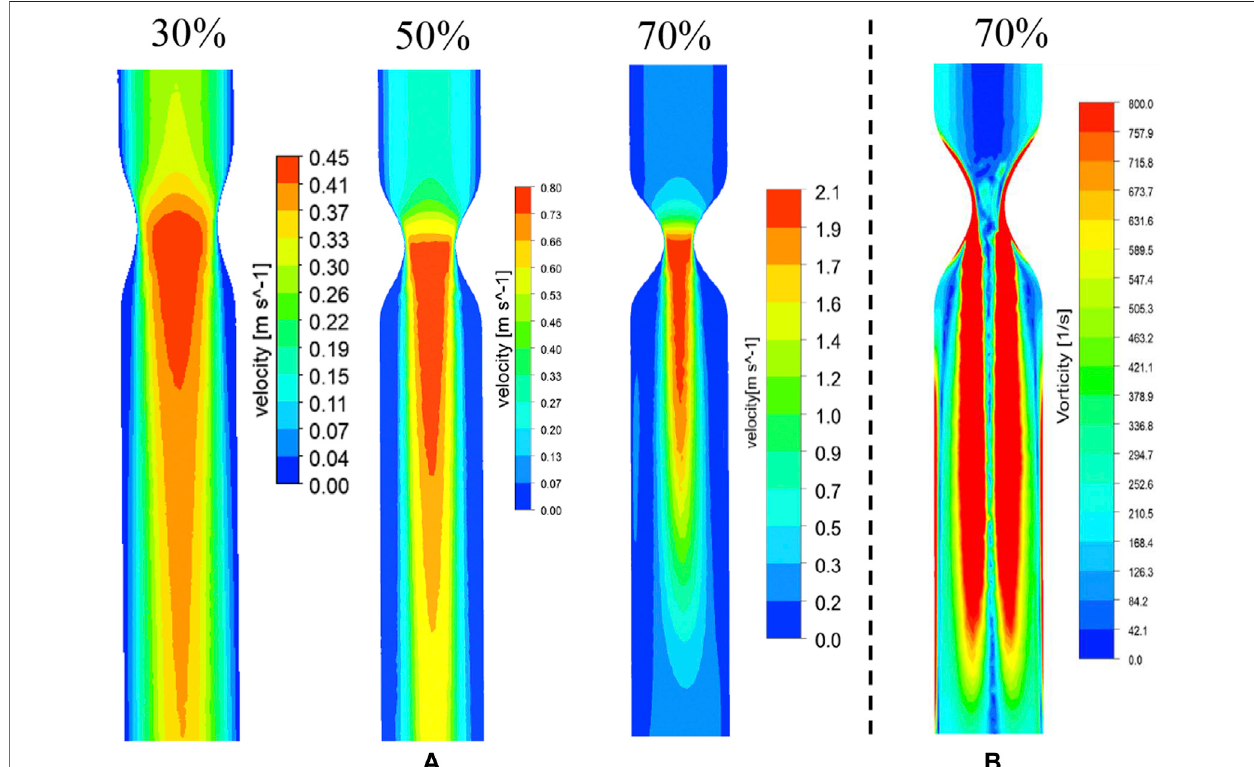
FIGURE 4 | CFD results of fl ow (A) and vorticity (B) distribution in vascular structures with different degrees of stenosis.